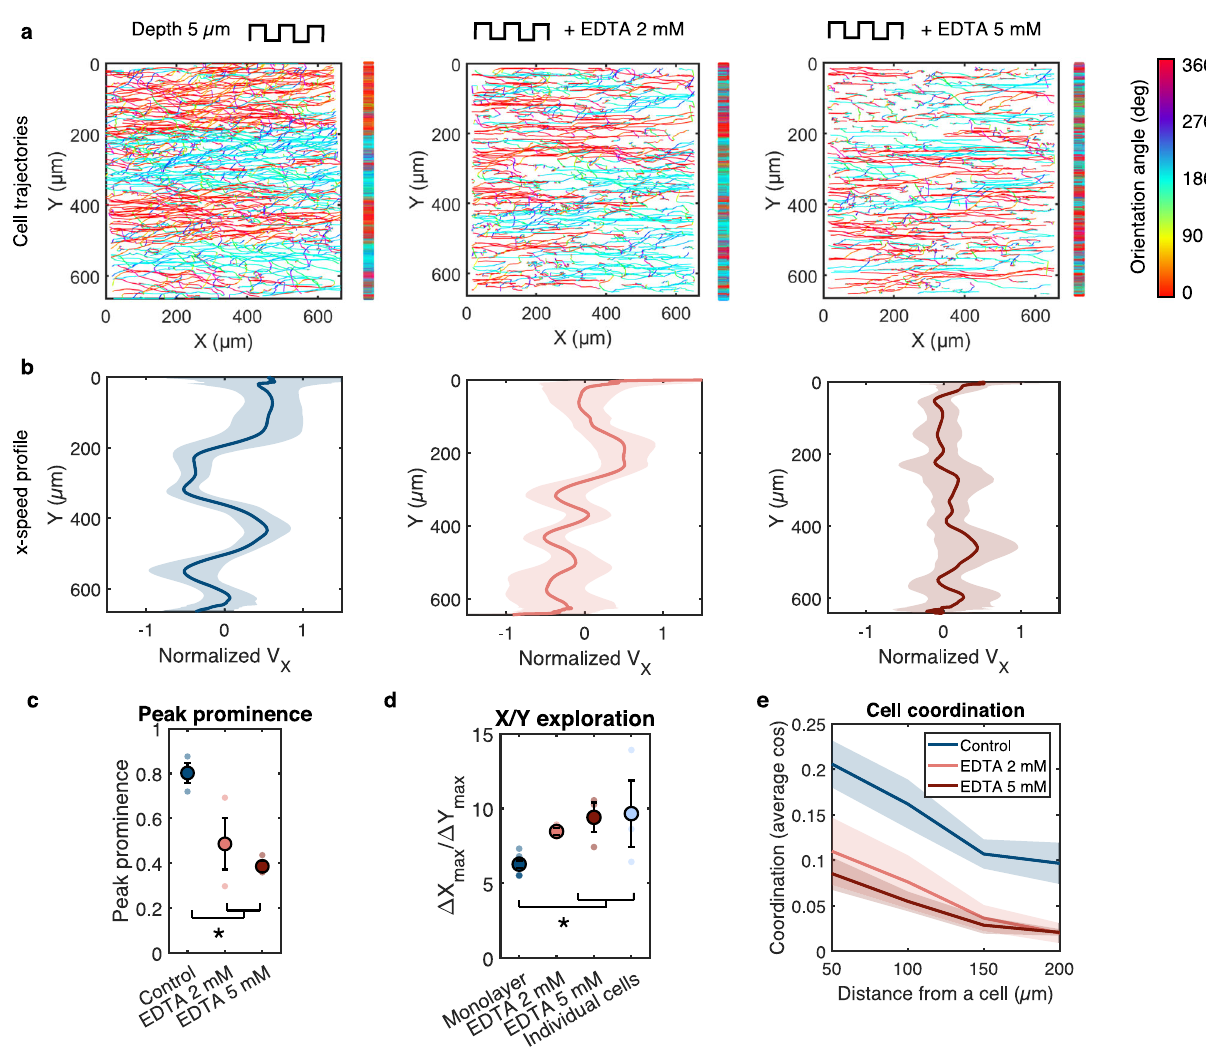
Fig. 3 The emergence of cell streams is dependent on cell-cell contacts. a Cell trajectories after 24 h of migration on grooves of width, spacing, and depth of 5 µ m with and without EDTA treatment. Trajectories are color-coded for orientation of displacement vectors. Vertical bars represent the projected trajectories on the y-axis. b Corresponding V x velocity pro fi les (normalized by the mean speed) along the y-axis averaged over time. Error bars represent standard deviations. c Peak prominence of V x pro fi les (de fi ned as the relative peak height compared to the surrounding baseline) . n = 3 independent experiments, one-way ANOVA, Tukey ’ s post-test (*, p < 0.01). d Ratio between x- and y-displacement (calculated as X max (cid:2) X min j each trajectory). The value for individual cells is shown for comparison. Monolayer n = 8 independent experiments, EDTA and individual cells n = 3 independent experiments. One-way ANOVA, Fishers ’ s post-test (*, p < 0.01). e Evolution of the cell coordination parameter with increasingly distant neighbors. Control n = 6 independent experiments, EDTA n = 3 independent experiments. For all graphs, error bars represent SEM. Source data are provided as a Source Data fi